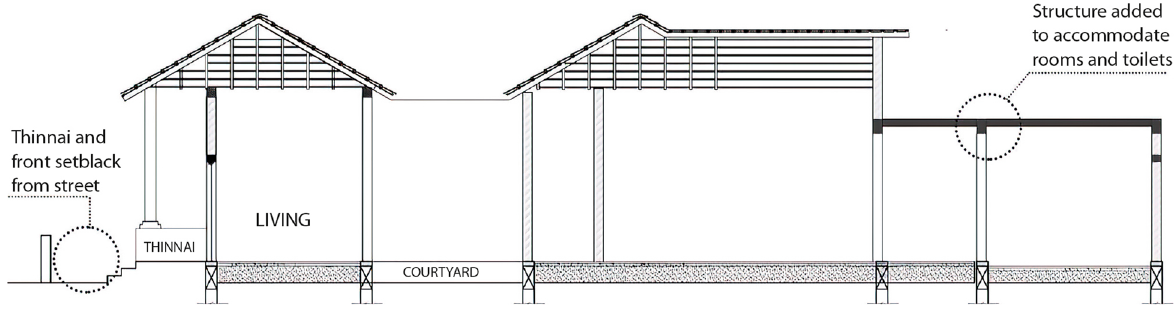
Fig. 20 Section of joint family dwelling (Source: the